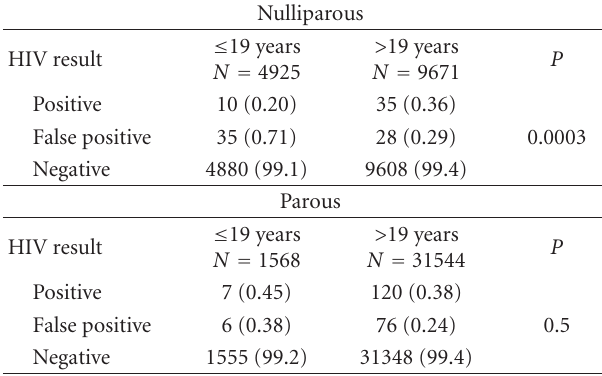
Table 3: HIV testing groups stratified by age and